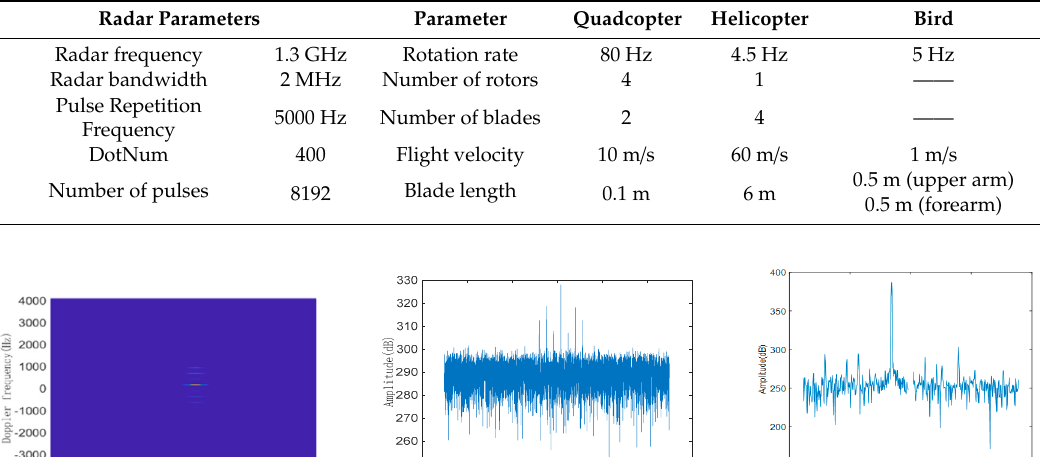
Figure 5. The specific process of obtaining the DMS.